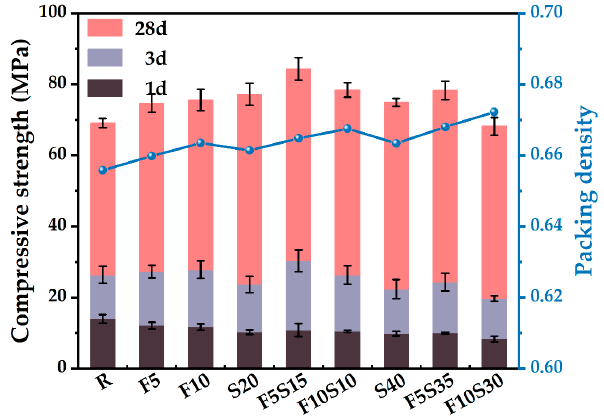
Figure 9. Effect of binder compositions on the compressive strength and packing